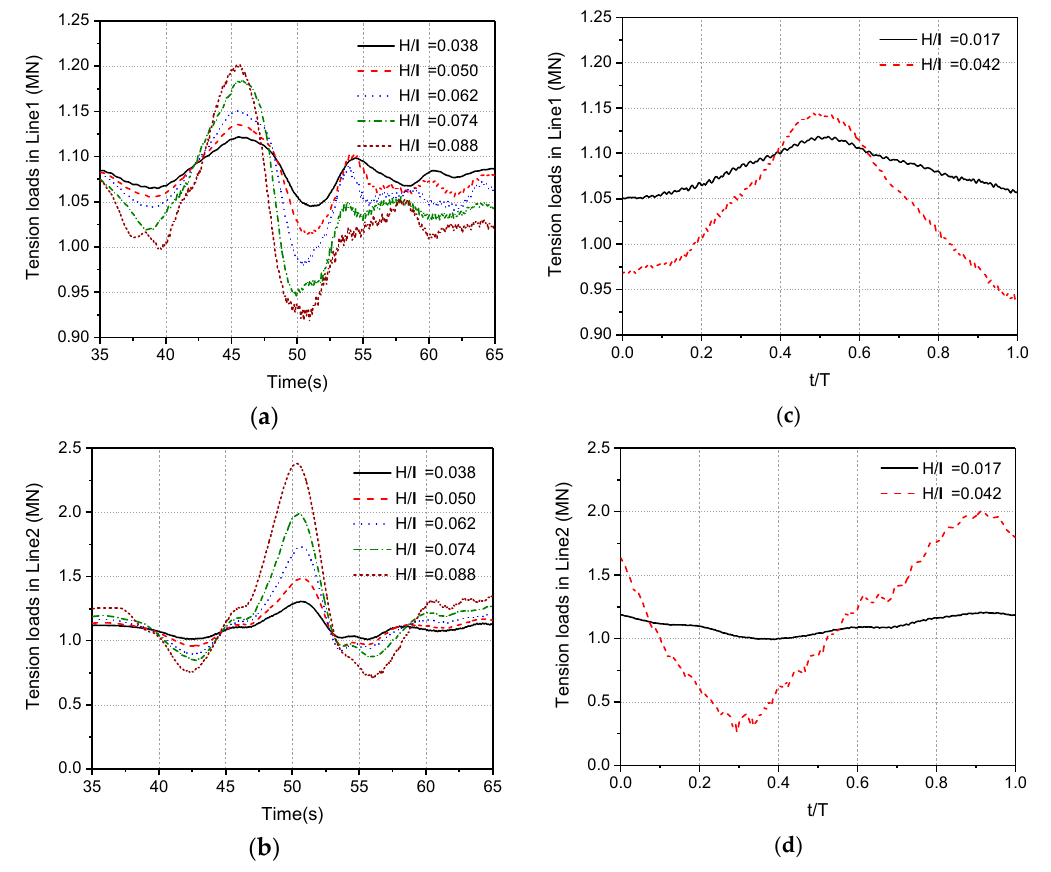
Figure 23. Tension loads of line 1 and line 2 under different focused waves (Case 1 to Case 5): ( a ) Tension loads of Line 1 under focused wave (Cases 1 to Case 5) ( b ) Tension loads of Line 2 under focused wave (Case 1 to Case 5) ( c ) Tension loads of Line 1 under focused wave (Cases 6 and Case 10) ( d ) Tension loads of Line 2 under regular wave (Cases 6 and Case 10).